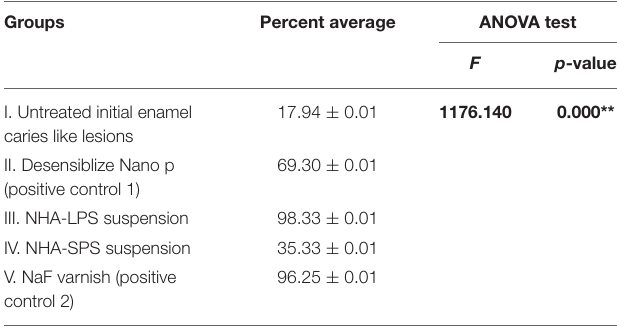
TABLE 7 | Statistical analysis of the average percentage values of dead bacterial in all tested groups.